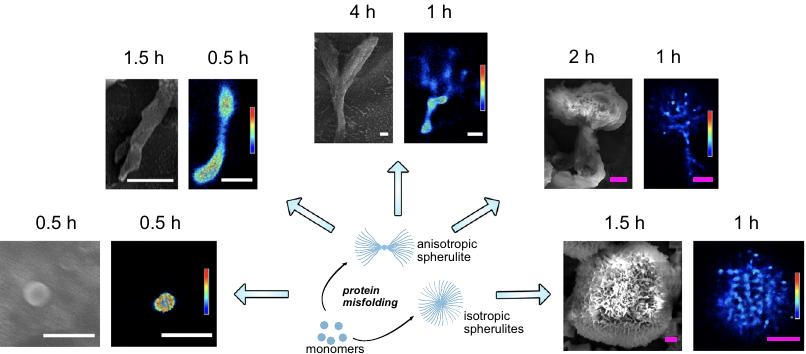
Fig. 1 SEM and super-resolution 3D dSTORM reconstructed images of the co-existing in solution morphologies of the anisotropically/isotropically grown structures of different HI aggregates. 3D dSTORM images: density plots, pseudocolor scale corresponds to neighbor localizations: the density of neighboring events within a 100 nm radius sphere from localization. Pseudocolor scale ranges from 0 to 1000 for the fi rst image on left and 0 to 400 for the rest. Scale bars in white color are 1 µ m and scale bars in purple color are 5